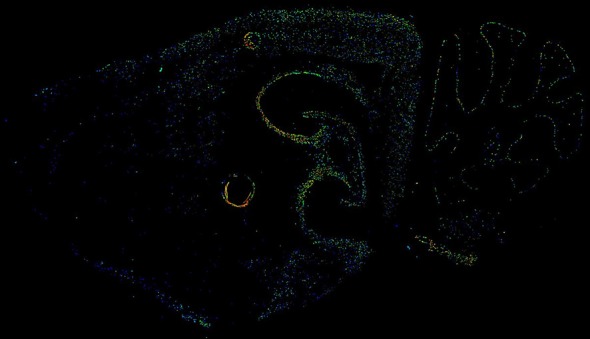
Image of expression of Apbb1ip in the young adult mouse brain, taken from the Allen Brain Atlas (Brain-Map; Lein et al., 2007; Sunkin et al., 2013; Zaldivar and Krichmar, 2014). The data is from Apbb1ip probe RP_050111_02_C07, with data taken from a sagittal cut from a 56-day old male C57BL/6J.